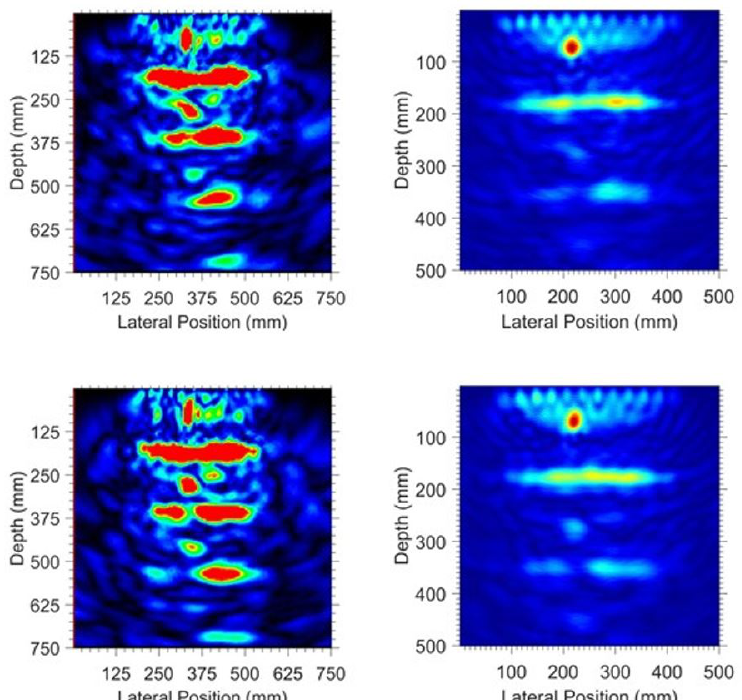
Figure 10. Standard (left) and evaluated (right) images of the other CS’ points over the 74 mm-deep dowel.